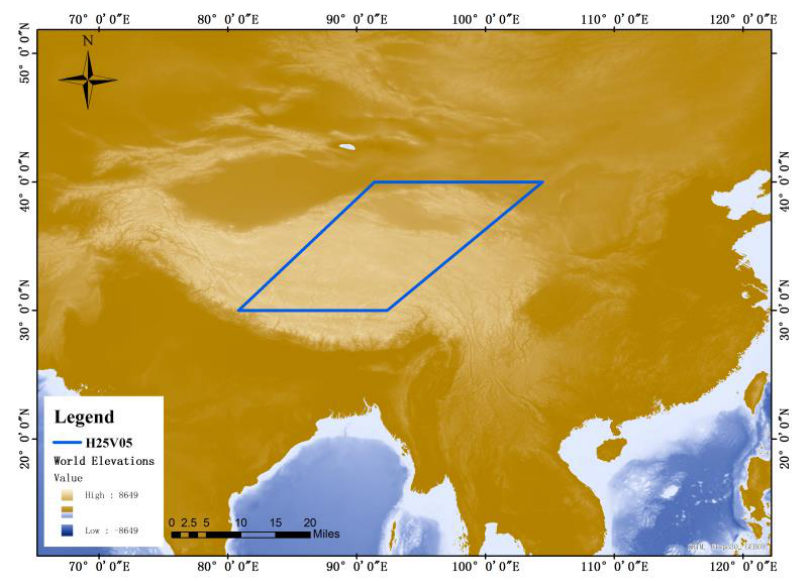
Figure 5. The blue box is the geographic location of the study area H25V05, which is located in the hinterland of the Qinghai − Tibet Plateau and contains a large amount of rugged